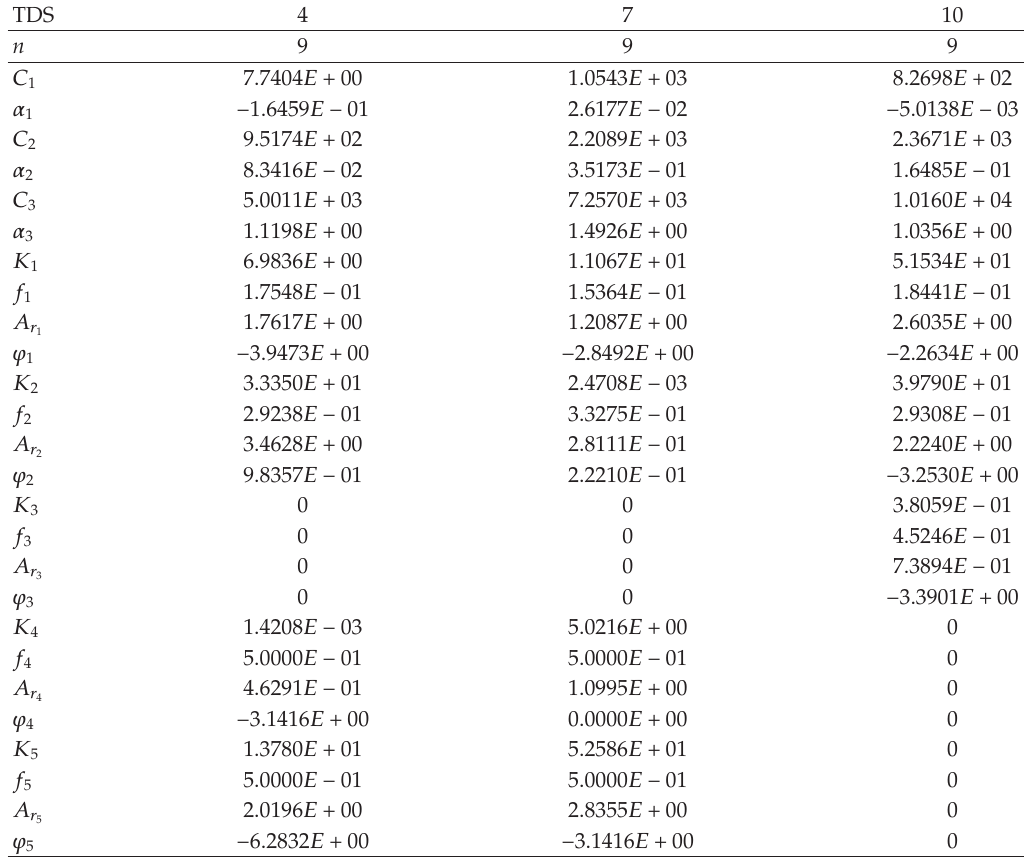
Please refer to Table 1 for the meanings of the terms.